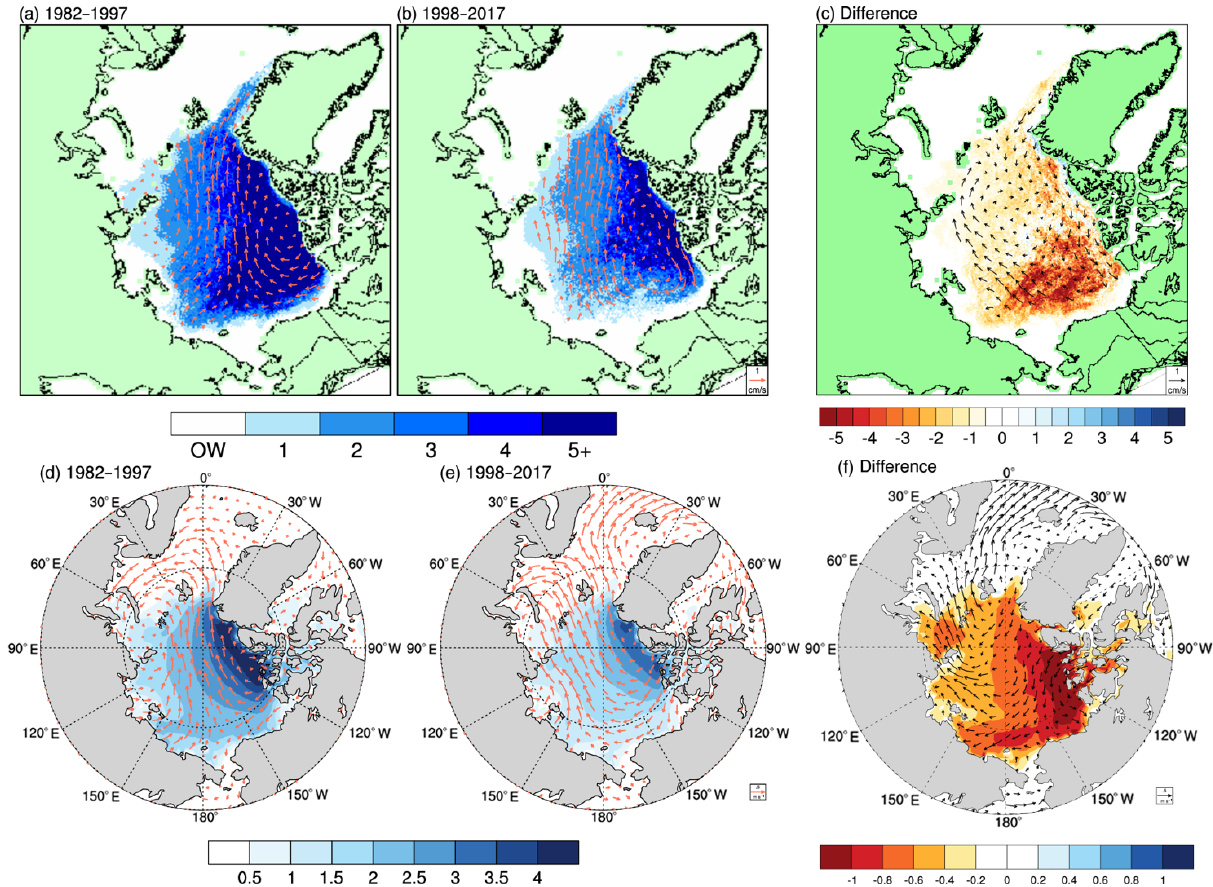
Figure 9. Regression pattern of sea ice motion onto the AD index and its difference (a, b, c) and regression pattern of surface wind onto the AD index and its difference (d, e, f) in the early (1982–1997, a, d ) and the recent (1998–2017, b, e ) period, respectively. The shaded areas denote the sea ice age (a, b, c) and the sea ice thickness (d, e, f) in September averaged over each period and its difference.